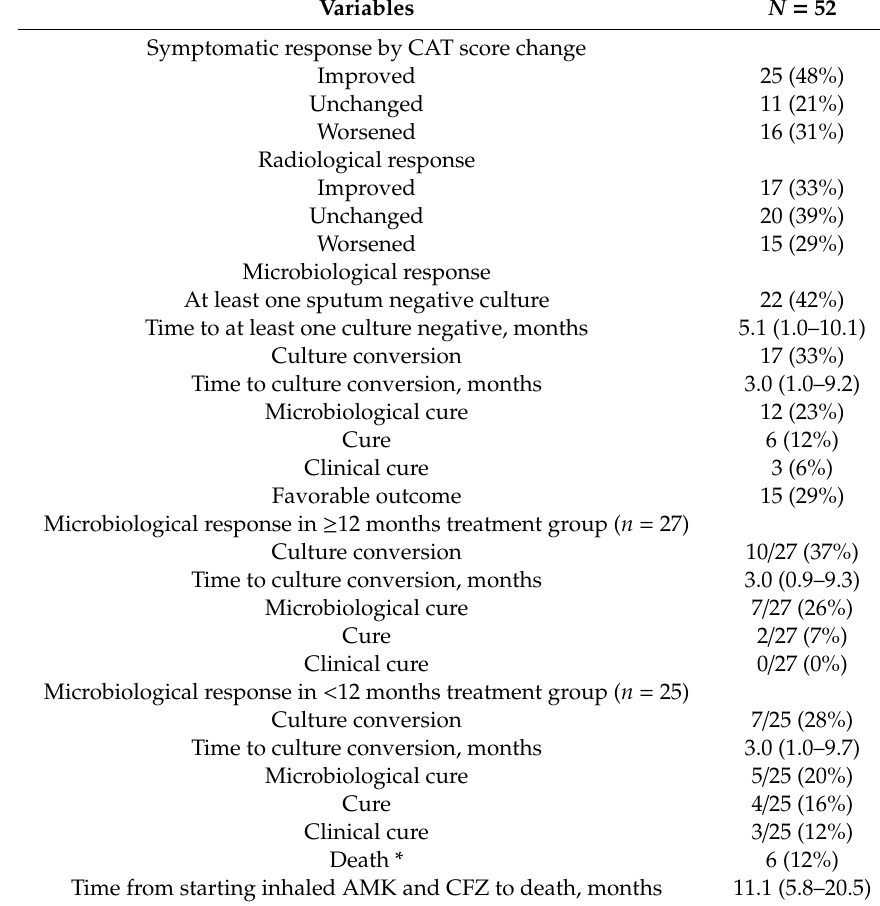
Table 3. Treatment response at the end of the inhaled AMK- and CFZ-containing regimens.